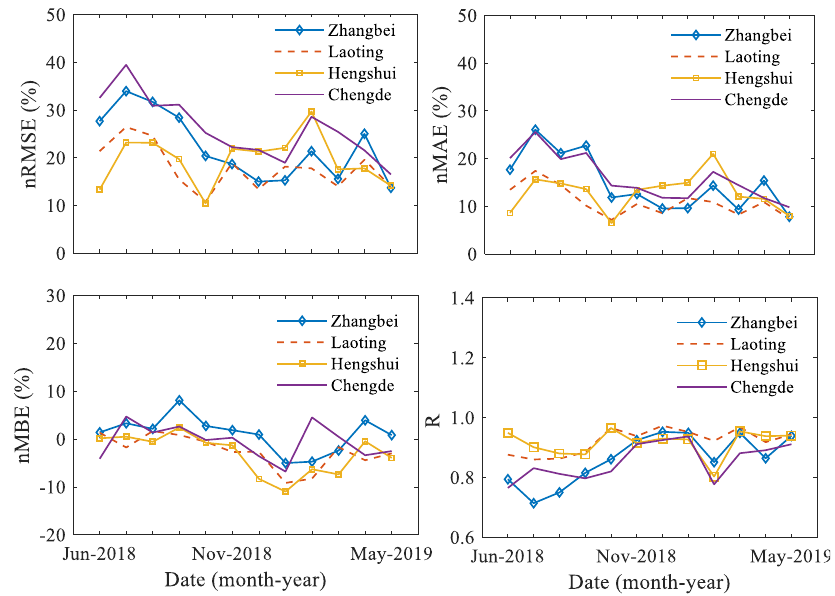
Figure 4. Monthly trend chart of the estimated GHI. nRMSE, normalized RMSE; nMAE, normalized mean absolute error; nMBE, normalized mean bias error.